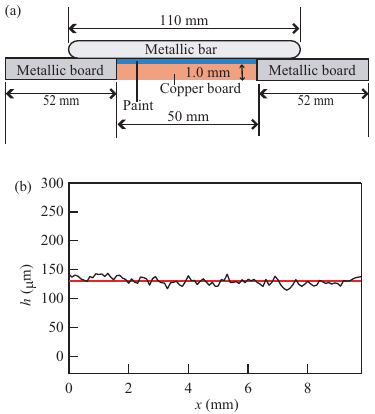
Figure 11. ( a ) Schematic drawing of the experimental setup for the application of a paint layer. Only the coated copper board is kept in a constant-temperature oven for several hours after the first coating. ( b ) The surface height h measured after